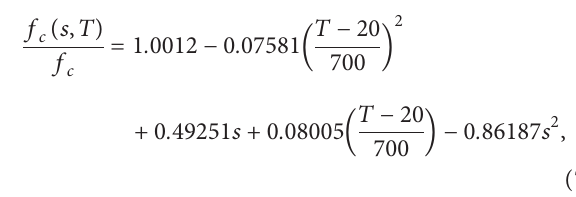
Figure 12: Relation between relative compressive strength and